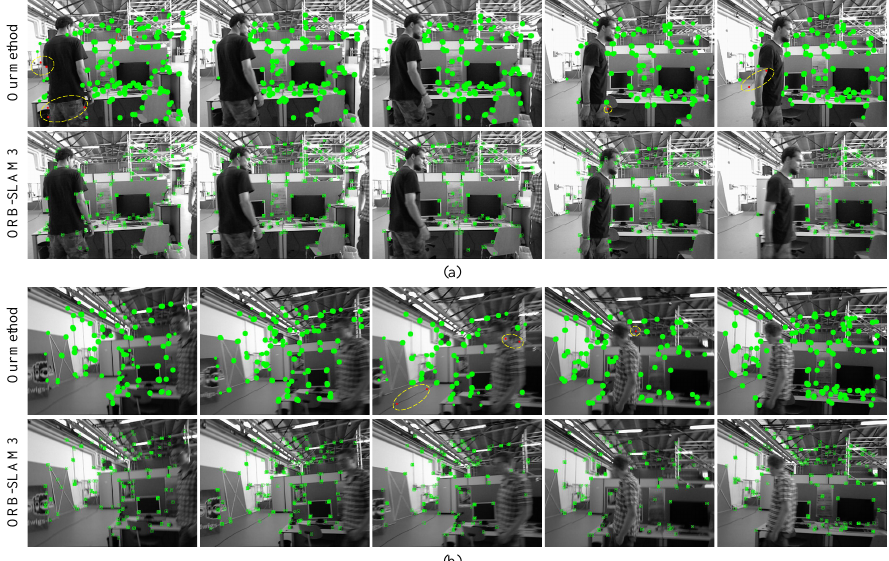
Figure 9. Some examples of the working process of the proposed method and ORB-SLAM3 in fr3/w/xyz: ( a ) environment with people moving at low speed; ( b ) environment with people moving at high speed. In our method, the red feature point means it connects to a D-MP; the green feature point means it connects to an R-MP or a U-MP. The larger the green feature point is, the more reliable the map point is. In our method, there are significantly fewer feature points on the